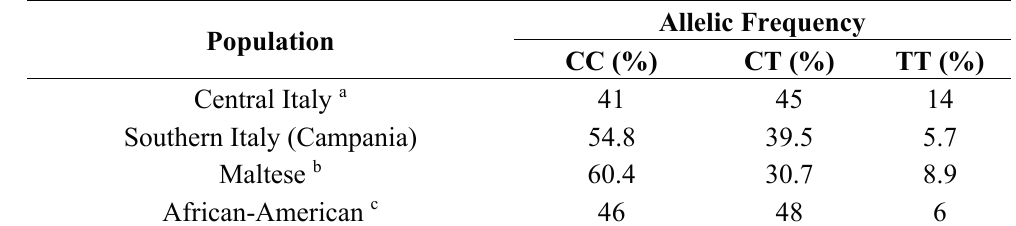
Table 2. Distribution of rs2228570 genotypes in different